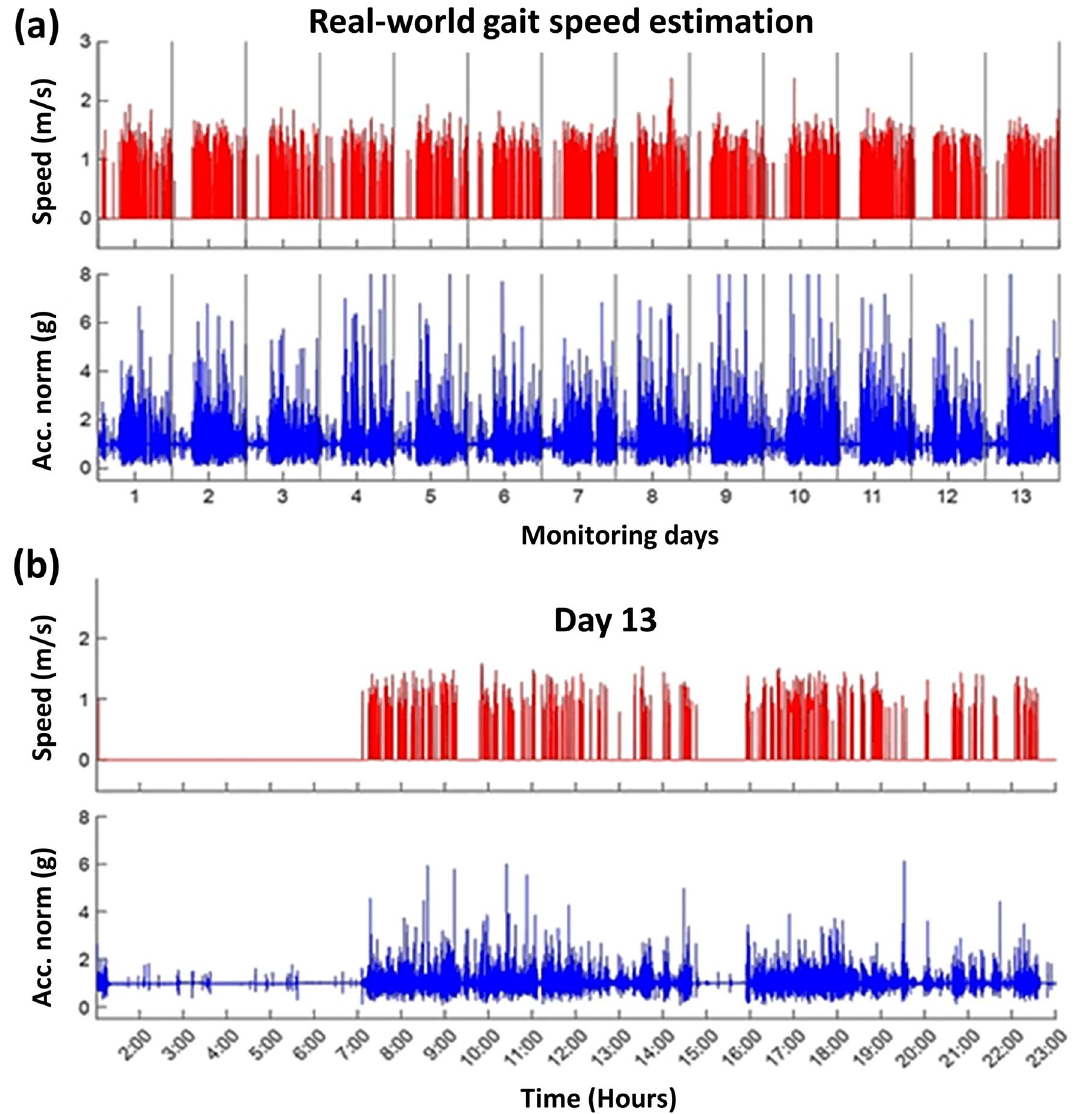
continuous days; (b) one typical day (day #12), (CoLaus cohort, Lausanne, Switzerland,